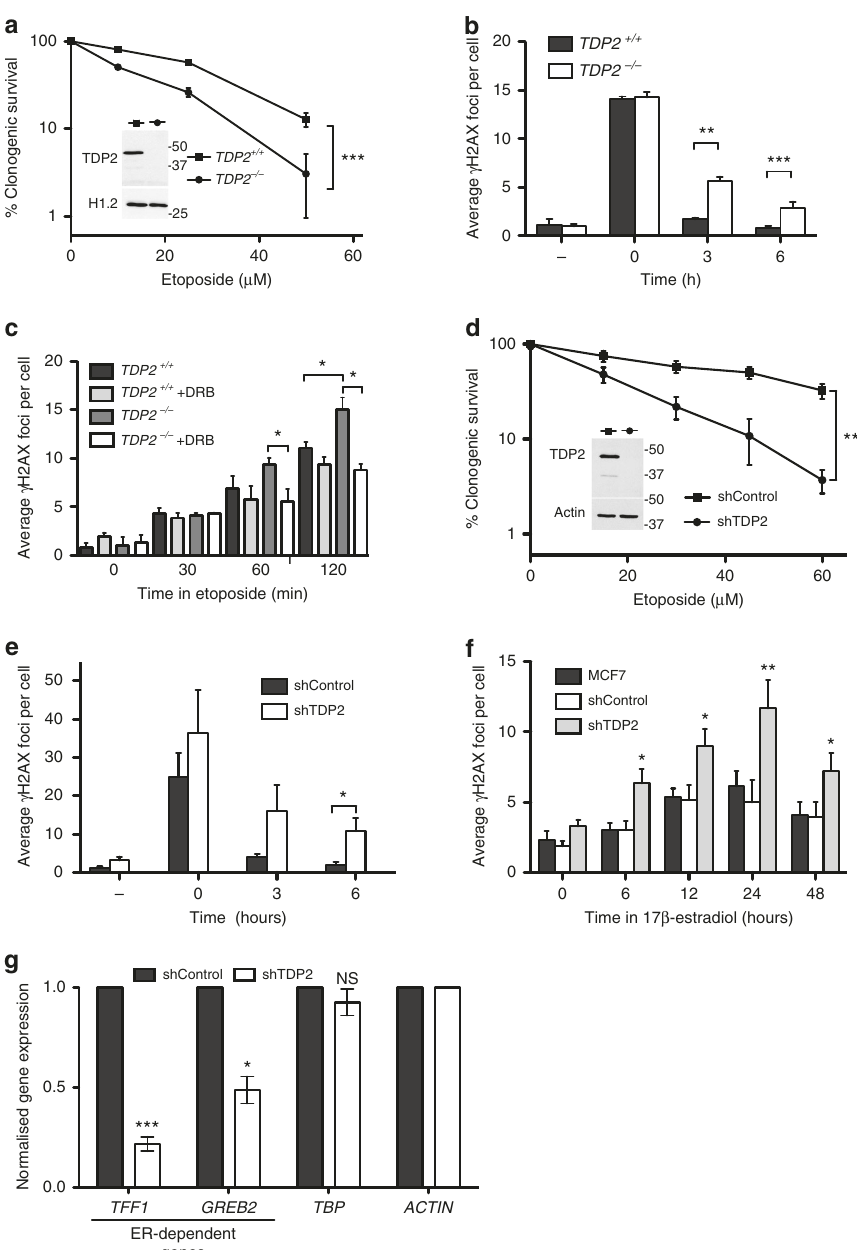
Fig. 2 TDP2 protects gene transcription from TOP2-induced DSBs. a Clonogenic survival of wild-type and TDP2 − / − RPE-1 cells following treatment (3h) with the indicated concentrations of etoposide. Data are the mean ( ± s.e.m.) of three independent experiments. Statistical signi fi cance was determined by two-way ANOVA (* P < 0.05, ** P < 0.01, *** P < 0.005). Molecular weight markers are in KDa. b The number of γ H2AX foci in wild-type and TDP2 − / − RPE-1 cells before and 30 min after treatment with 20 µ M etoposide, and after the indicated repair periods in drug-free medium. Data are the mean ( ± s.e.m.) of at least three independent experiments. Statistical signi fi cance was determined by T -tests (* P < 0.05, ** P < 0.01, *** P < 0.005). c The number of γ H2AX foci in serum-starved wild-type and TDP2 − / − RPE-1 cells was measured following treatment with 5 µ M etoposide. Where indicated, cells were pre-incubated with the transcription inhibitor DRB (100 µ M) for 3 h prior to etoposide treatment. Other details are as in b . d Clonogenic survival of mock-depleted (shControl) or TDP2-depleted (shTDP2) MCF7 cells following treatment (3h) with the indicated concentrations of etoposide. Other details are as in a . e The number of γ H2AX foci in mock-depleted (shControl) or TDP2-depleted (shTDP2) MCF7 cells before and 30 min after treatment with 20 µ M etoposide, and after the indicated repair periods in drug-free medium. Other details as in b . f The number of γ H2AX foci in untransfected MCF7 cells or in mock-depleted (shControl) or TDP2-depleted (shTDP2) MCF7 cells following incubation for the indicated times with 100 nM 17 β -estradiol. Data are the mean ( ± s.e.m.) of fi